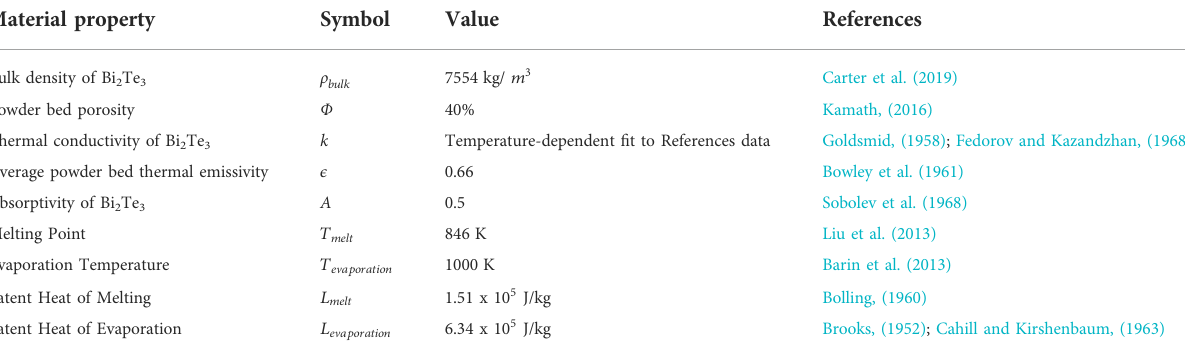
TABLE 1 Material properties of Bi 2 Te 3 powder bed used in the simulations. Though not used in the article, the notations T melt , T evaporation , L melt and L evaporation were used in the FEM code, so they are provided here for